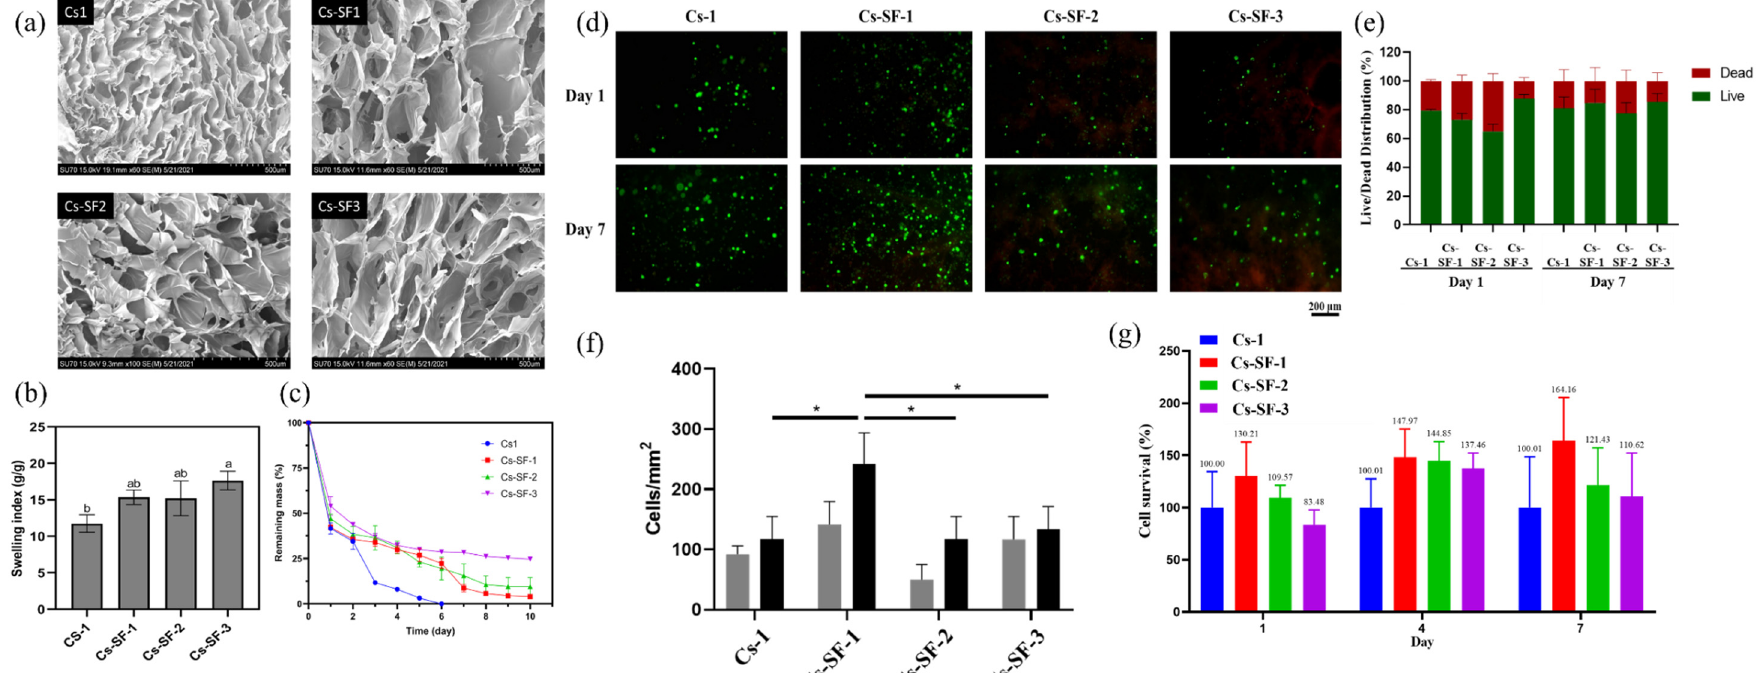
Figure 4. ( a ) Microporous structure of Cs-1, Cs-SF1, Cs-SF2, and Cs-SF3 hydrogels; ( b ) swelling index of freeze-dried hydrogels in PBS solution (10 mM) at 37 °C; ( c ) degradation behavior of Cs-1 and Cs-SF hydrogels in lysozyme solution at 37 °C—a, b bars that do not share a letter are significantly different at p < 0.05; ( d ) cell viability and proliferation fluorescence microscopic images of LIVE/DEAD staining of ovarian stromal cells encapsulated in Cs-1, Cs-SF-1, Cs-SF-2, and Cs-SF-3 on day 1 and 7—scale bar indicates 200 µm; ( e ) LIVE/DEAD distribution of ovarian stromal cells encapsulated in Cs-1, Cs-SF-1, Cs-SF-2, and Cs-SF-3 on day 1 and 7; ( f ) quantification of viable cells from LIVE/DEAD staining, using ImageJ software (https://imagej.nih.gov/ij/ (accessed on 1 September 2021))—asterisk marks (*) significant differences at p < 0.05; ( g ) graph showing cell survival obtained by PrestoBlue analysis on day 1, 4, and 7 (mean ± S.D.; n = 3).